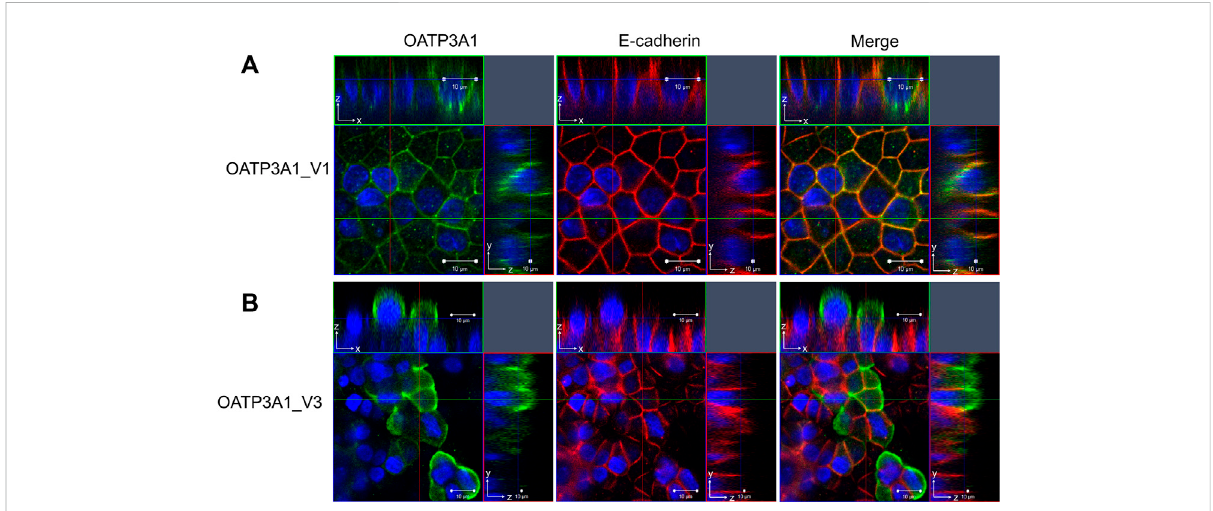
FIGURE 6 SubcellularlocalizationofOATP3A1_V1andOATP3A1_V3inpolarizedMDCKIIcells.MDCKIIcellsoverexpressingOATP3A1variantsweregrown on a permeable membrane support to form polarized cultures. Double immunostaining was performed with an antibody recognizing the lateral membrane marker E-cadherin (red) and the (A) pan anti-OATP3A1 antibody (OATP3A1_V1) or (B) anti-OATP3A1_V3 antibody (green). Right panels depict the overlay. OATP3A1_V1 is localized at the basolateral membrane and shows colocalization (yellow) with E-cadherin. Nuclei were stained with DAPI (blue). Optical XY sectioning with the corresponding XZ- or YZ-section was performed by confocal laser scanning microscopy. Representative images are